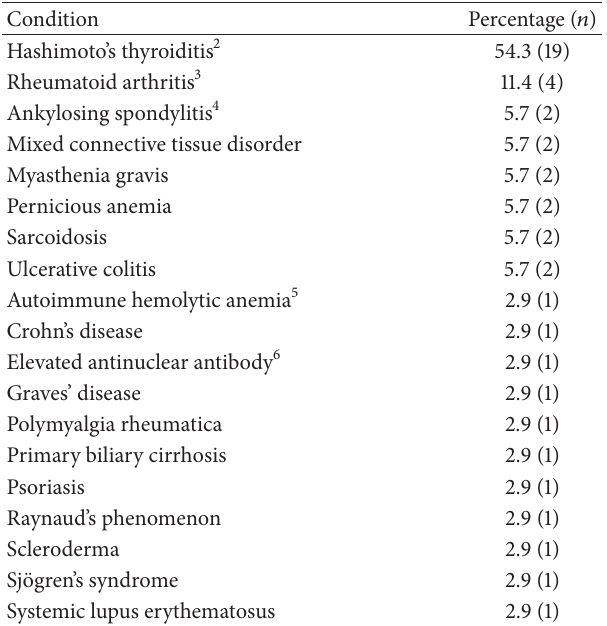
Table 2: Autoimmune conditions in 35 hemochromatosis pro- bands 1